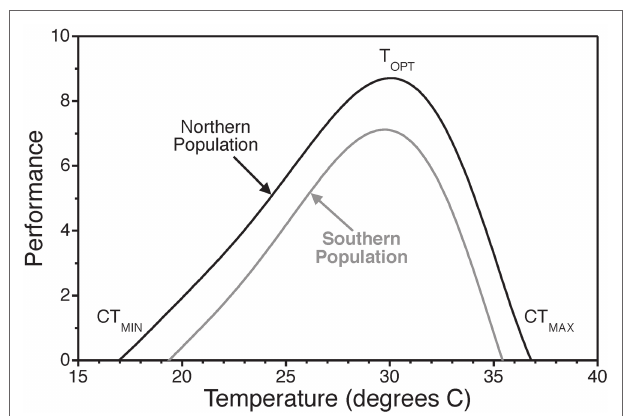
FIGURE 1 | Thermal performance curve illustrating the typical pattern of physiological performance as a function of temperature. Thermal performance curves are characterized by an optimal temperature T OPT where performance is maximized. They also exhibit critical thermal minima CT MIN and critical thermal maxima CT MAX where performance declines to zero. Scales on the x and y axes are arbitrary and simply used to illustrate general patterns of thermal responsiveness. Optimal temperatures, the range from critical thermal minima to the critical thermal maxima, and the width of curves vary across biological scales of organization, among individuals, among populations (i.e., countergradient variation), and among